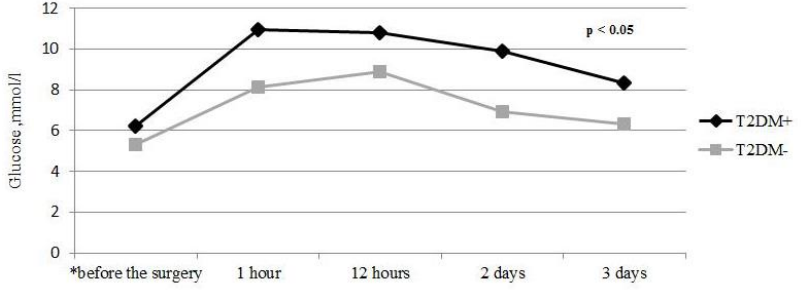
Figure 1. Glucose levels dynamics in patients with and without T2DM in the perioperative period according to CGMS, mmol/L. * Glucose levels in patients with T2DM ( Ме (Q25; Q75)) before the surgery—6.02 (5.5; 8.28); 1 h after the surgery—10.95 (9.48; 13.2);12 h after the surgery—10.8 (9.14;